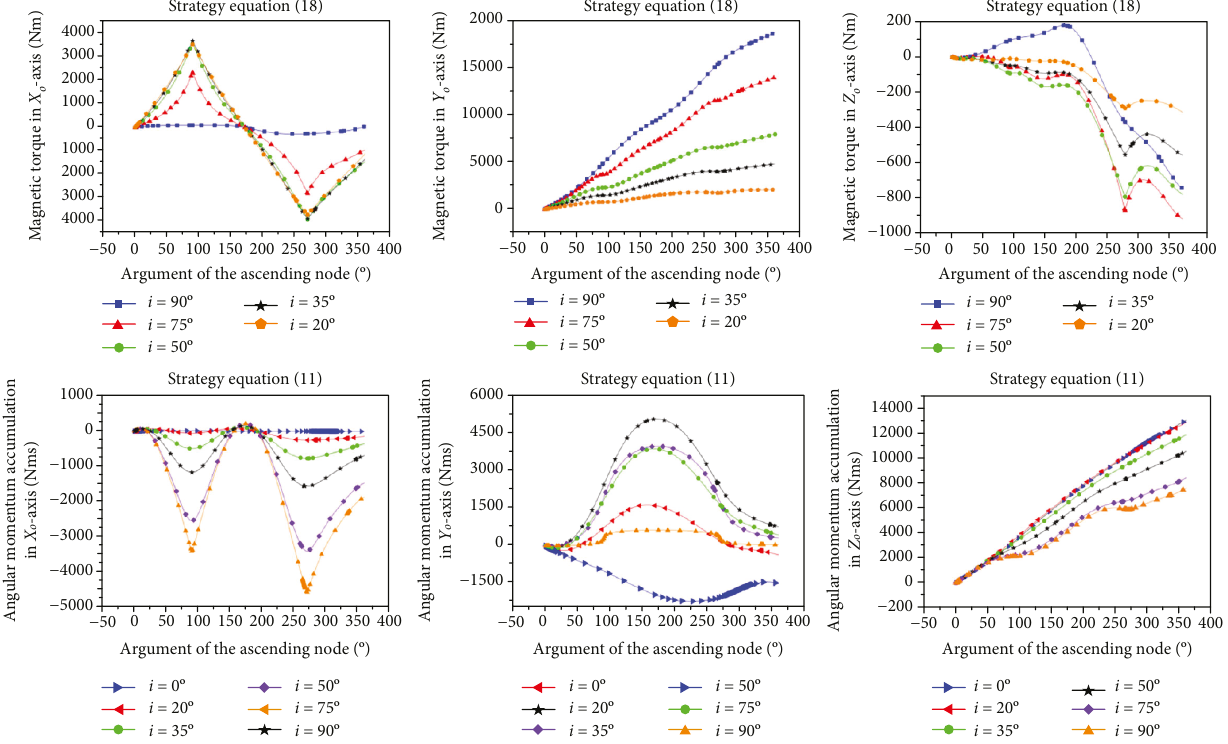
Figure 9: Angular momentum accumulation (orbital coordinates) in di ff erent inclination circular orbits (950km) under equations (11) and (18) (example 5).